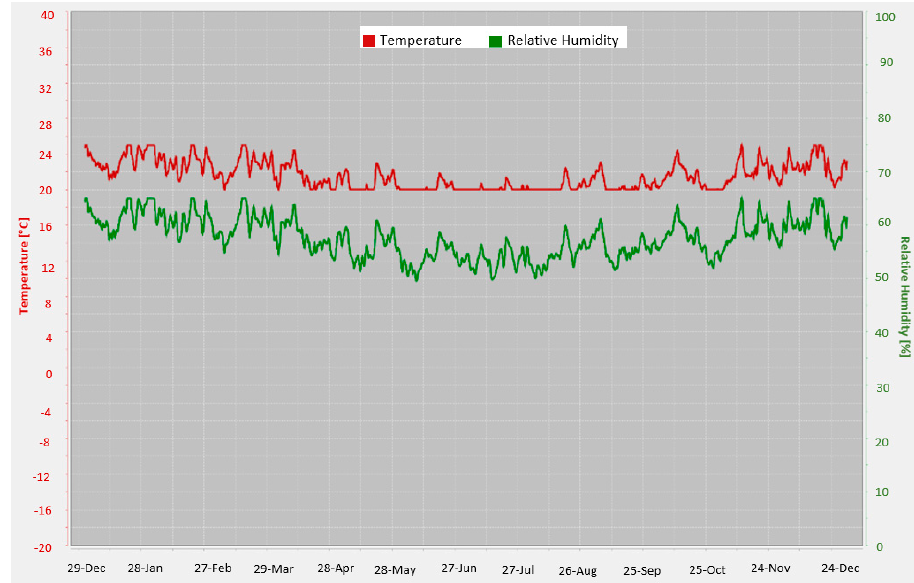
Figure 4. Graph showing the interior temperature and relative humidity profiles for EN − 15026, DIN − 4108, and WTA6 − 2.